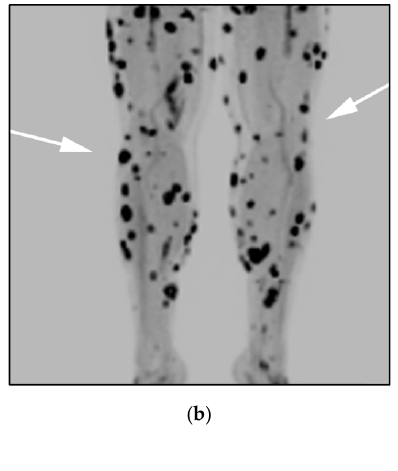
hypermetabolic cutaneous and subcutaneous lesions within the trunk as well as the limbs (white arrows) ( c ) F-18 FDG PET/CT axial, shows hypermetabolic nodular mass in the mid posterior abdominal wall (white arrows) ( d ) Histologic section from subcutaneous tissue shows monotonous medium-to-large neoplastic lymphoid cells encircling fat lobules in a lacelike distribution. The neoplastic cells show hyperchromatic nuclei. Note the vacuolated macrophages containing karyorrhectic debris. (Original magnification 400 ×, H&E stain)